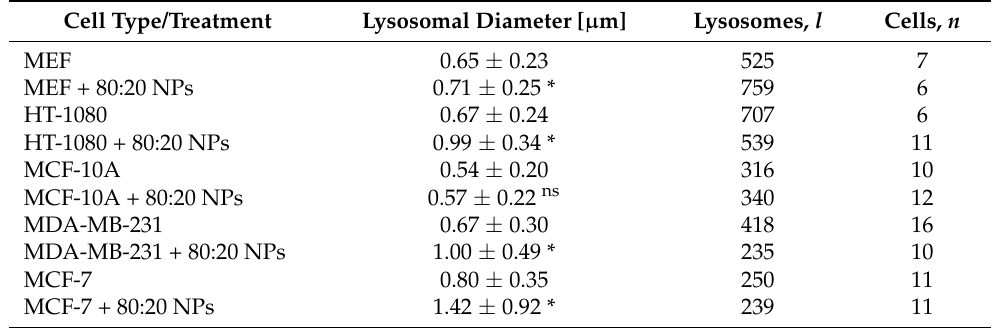
Table A2. Lysosomal diameters in all cell types. Lysosome sizes in all cell types analyzed in the present study without or with 80:20 NP treatment were quantified from confocal midplane images of Lysotracker-stained organelles. Data = mean ± s.d. A two-tailed Student’s t-test with unequal variances between control and NP-treated groups. * p < 0.05; ns = not significant. Data are from Borkowska et al., 2020